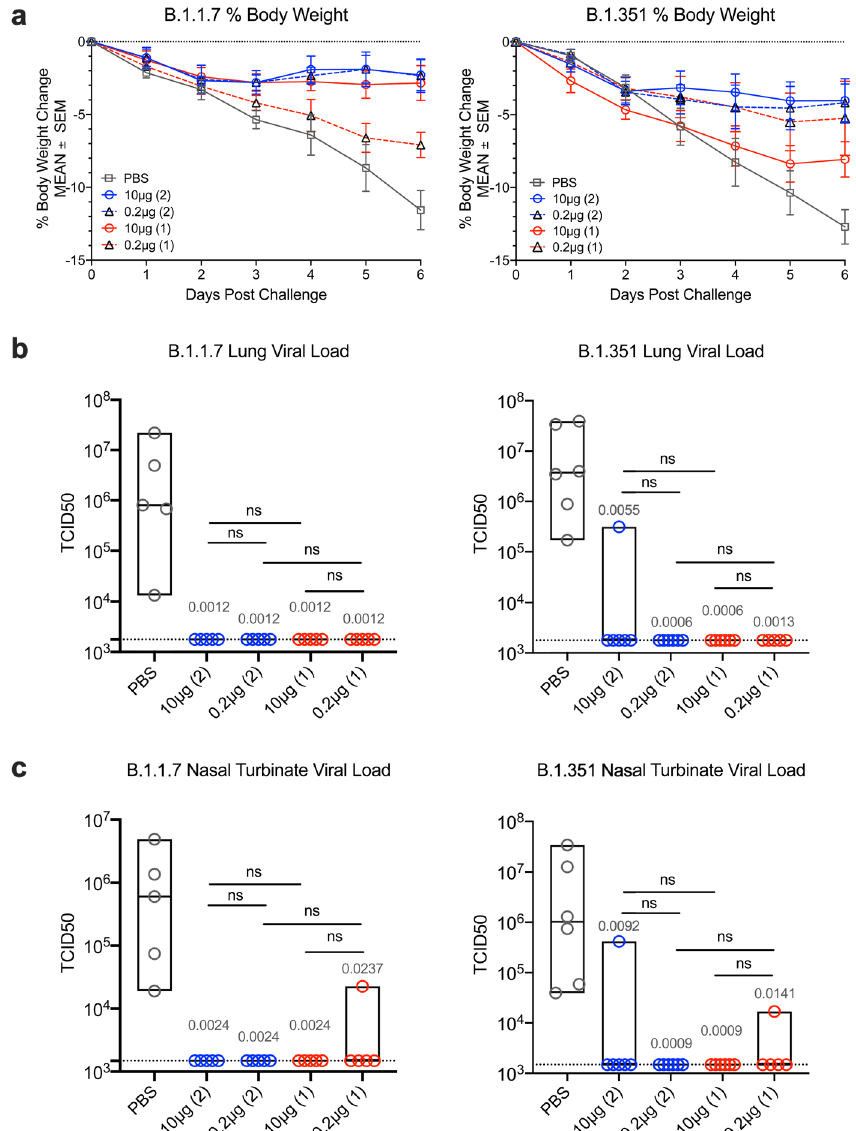
Fig. 3 Body weight changes and lung viral load post-challenge. Daily weights were gathered on hamsters from the time of viral challenge to necropsy on day 6 post challenge when lungs were harvested for a whole tissue, culture based viral load assessment in Vero TMPRSS2 cells. a Mean percent body weight changes plus and minus standard error of the mean (SEM) are given on the y -axis for groups of hamsters assigned to phosphate buffered saline control (PBS) or SpFN-ALFQ vaccination from day of challenge (day 0) to day of necropsy (day 6) for either B.1.1.7 or B.1.351 challenge. Data from immunization groups are given in each graph as PBS (gray plot, phosphate buffered saline control) or active immunogen dose (blue circle/ blue solid line, 10 μ g 2-dose regimen; black triangle/ blue dotted line, 0.2 μ g 2-dose regimen; red circle/red solid line, 10 μ g 1-dose regimen; black triangle/red dotted line, 0.2 μ g 1-dose regimen. Number of vaccinations in the vaccine regimen are also given parenthetically within each graph. b SARS-CoV-2 viral load data from lung tissue harvested on day 6 post challenge is given on the y -axis as the tissue culture infective dose, 50% (TCID50) per gram of tissue as titered on Vero TMPRSS2 cells and read out by cytopathic effects for either B.1.1.7 and B.1.351 challenged hamsters. Immunization groups are given on the x-axis as PBS (control (gray circles); 10 μ g and 0.2 μ g 2-dose vaccine regimens (blue circles); 10 μ g and 0.2 μ g 1-dose vaccine regimens (red circles). c SARS-CoV-2 viral load data from nasal turbinate tissue harvested on day 6 post challenge is given as in b . Group data are displayed as box plots with the top and bottom bars of the box the standard deviation and the center line as median group values. The dotted horizontal line is the lower limit of detection of the assay. p -values for SpFN-ALFQ vaccination groups compared with PBS control are given just above the boxes in light gray while intra-active regimen p -values are given above the boxes in black. ns not signi fi cant ( p > 0.05) using the Kruskal – Wallis multiple comparisons test, with Dunn ’ s intermediate levels of protection after a single immunization. In loss of body weight in control animals. In the 2-dose regimen in the case of B.1.351, protection in the 2-dose regimen had a similar both the 10 μ g and 0.2 μ g groups for B.1.1.7, loss of bodyweight range of protection, from the ~13% bodyweight loss observed in was dramatically reduced, from ~12% observed in the PBS control the PBS treated animals to 3 – 4%. Vaccine 1-dose regimens were animals to between 2 – 3% in the vaccinated groups. Notably, a less protective than observed for B.1.1.7 challenge, but still single vaccination using 10 μ g of SpFN-ALFQ was also suf fi cient to conferred intermediate protection against B.1.351 challenge. confer similar protection, with even the 0.2 μ g conferring